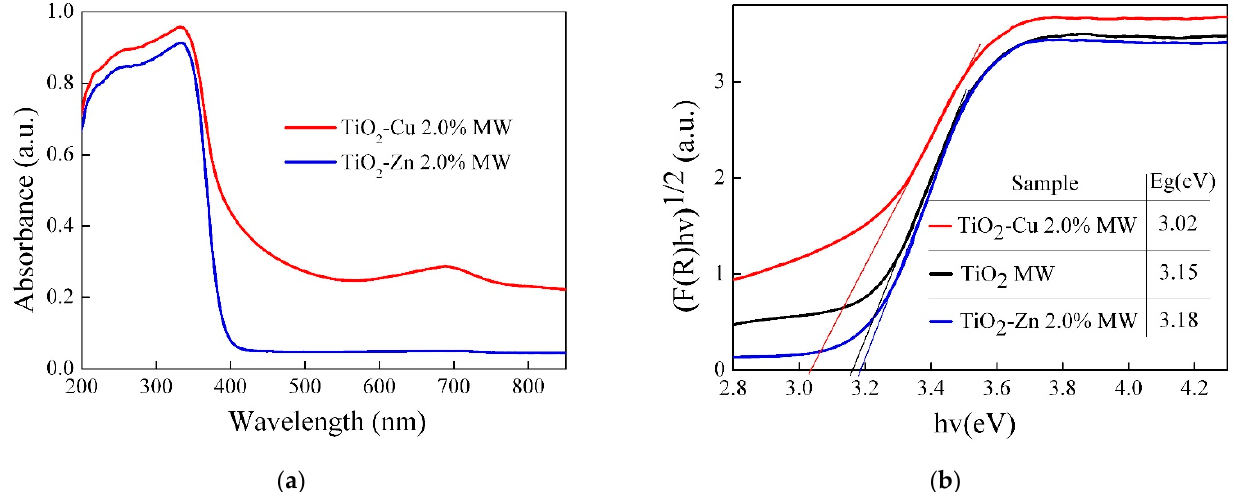
Figure 15. UV − Vis absorption spectra of ( a ) Cu/Zn-doped TiO 2 MW samples and ( b ) graphic representation of the Kubelka–Munk function for indirect transitions.